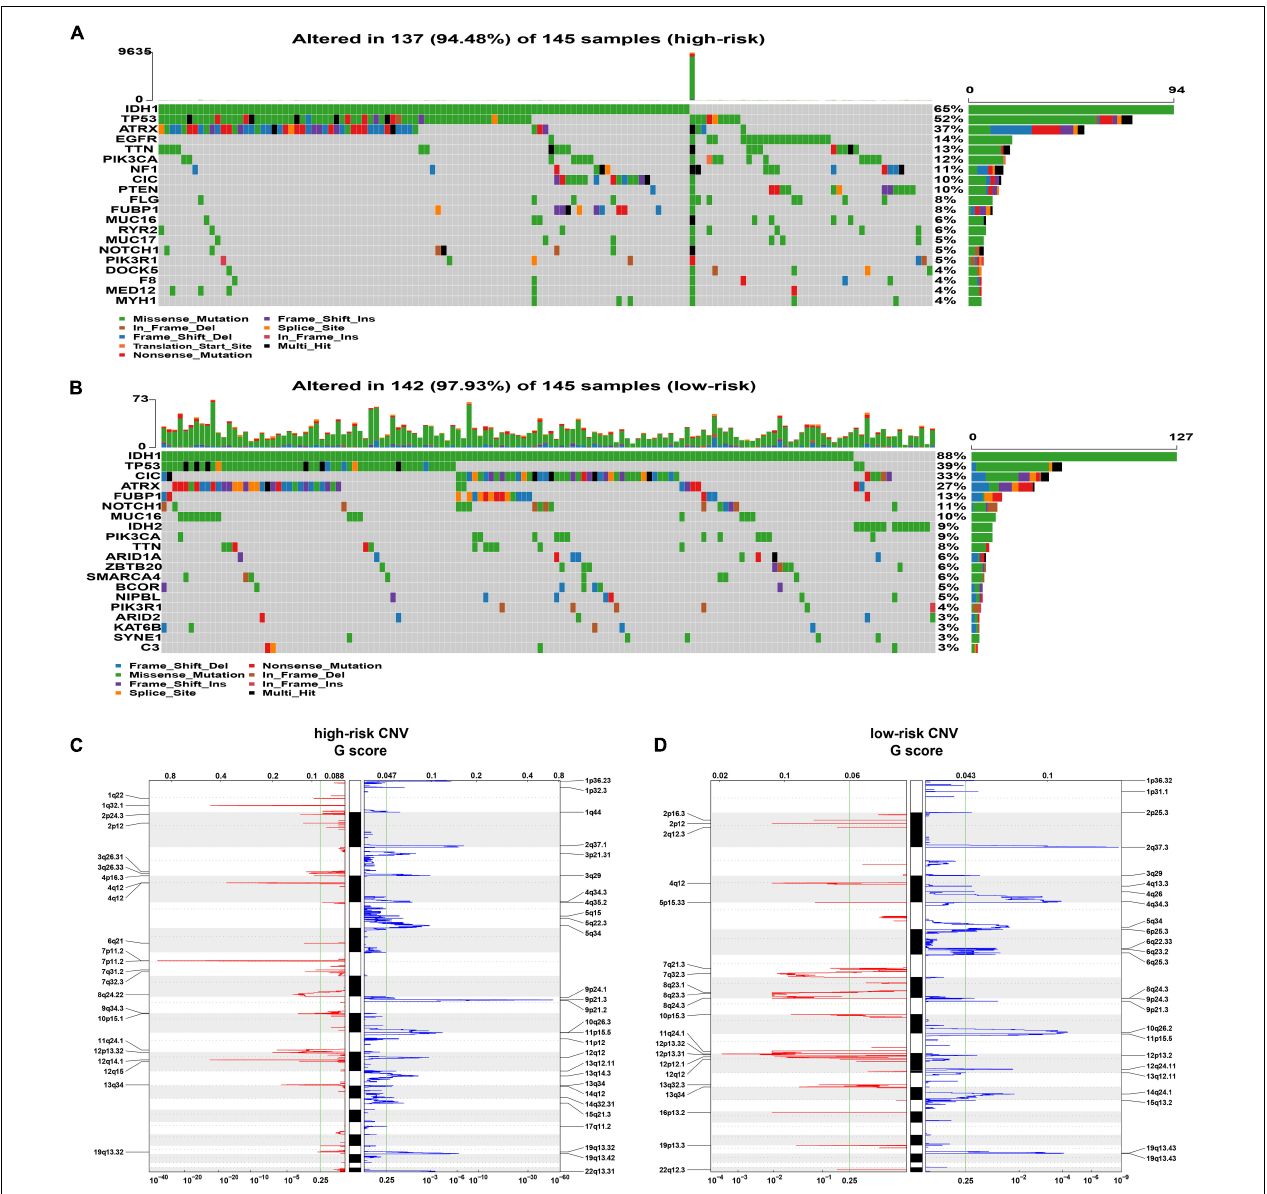
FIGURE 5 | Analysis of genomic alterations. (A,B) The somatic mutation profiles in high-risk (A) and low-risk (B) groups. (C,D) The analysis of CNV. The deleted (blue) and amplified (red) chromosomal regions in high- panel (C) and low-risk panel (D) groups; q value = 0.25 as the threshold (the green